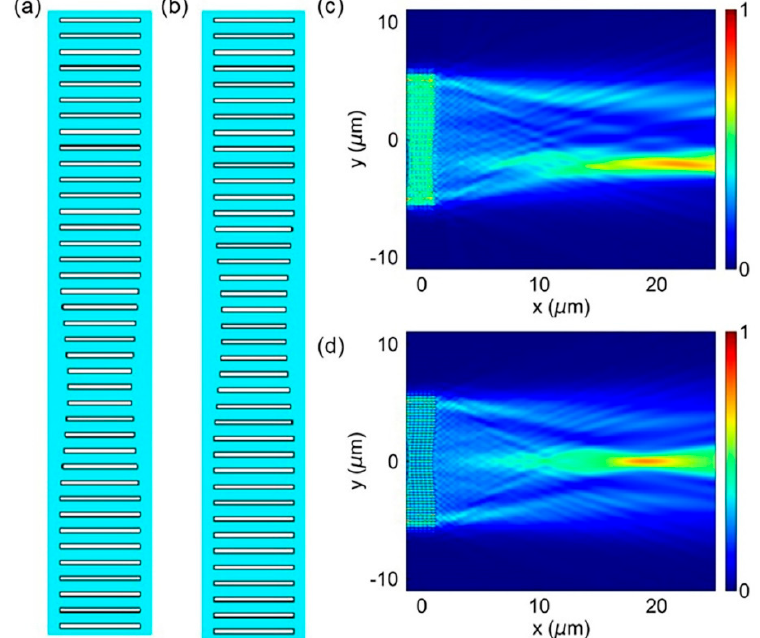
Figure 3. The design of on-chip oracle metasurface and MMS. ( a ) The structure diagram of the proposed oracle metasurface. ( b ) The structure diagram of the proposed MMS. ( c , d ) Simulation results for the in-plane wave distribution of |E y | 2 in the middle of the silicon slab with incident light parallel to its optical axis are applied: ( c ) oracle metasurface, ( d )